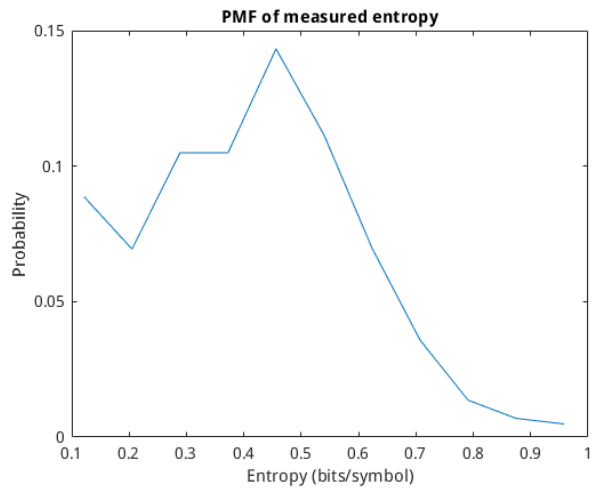
Figure 7. PMF of calculated single-cell entropy based on output spike trains.